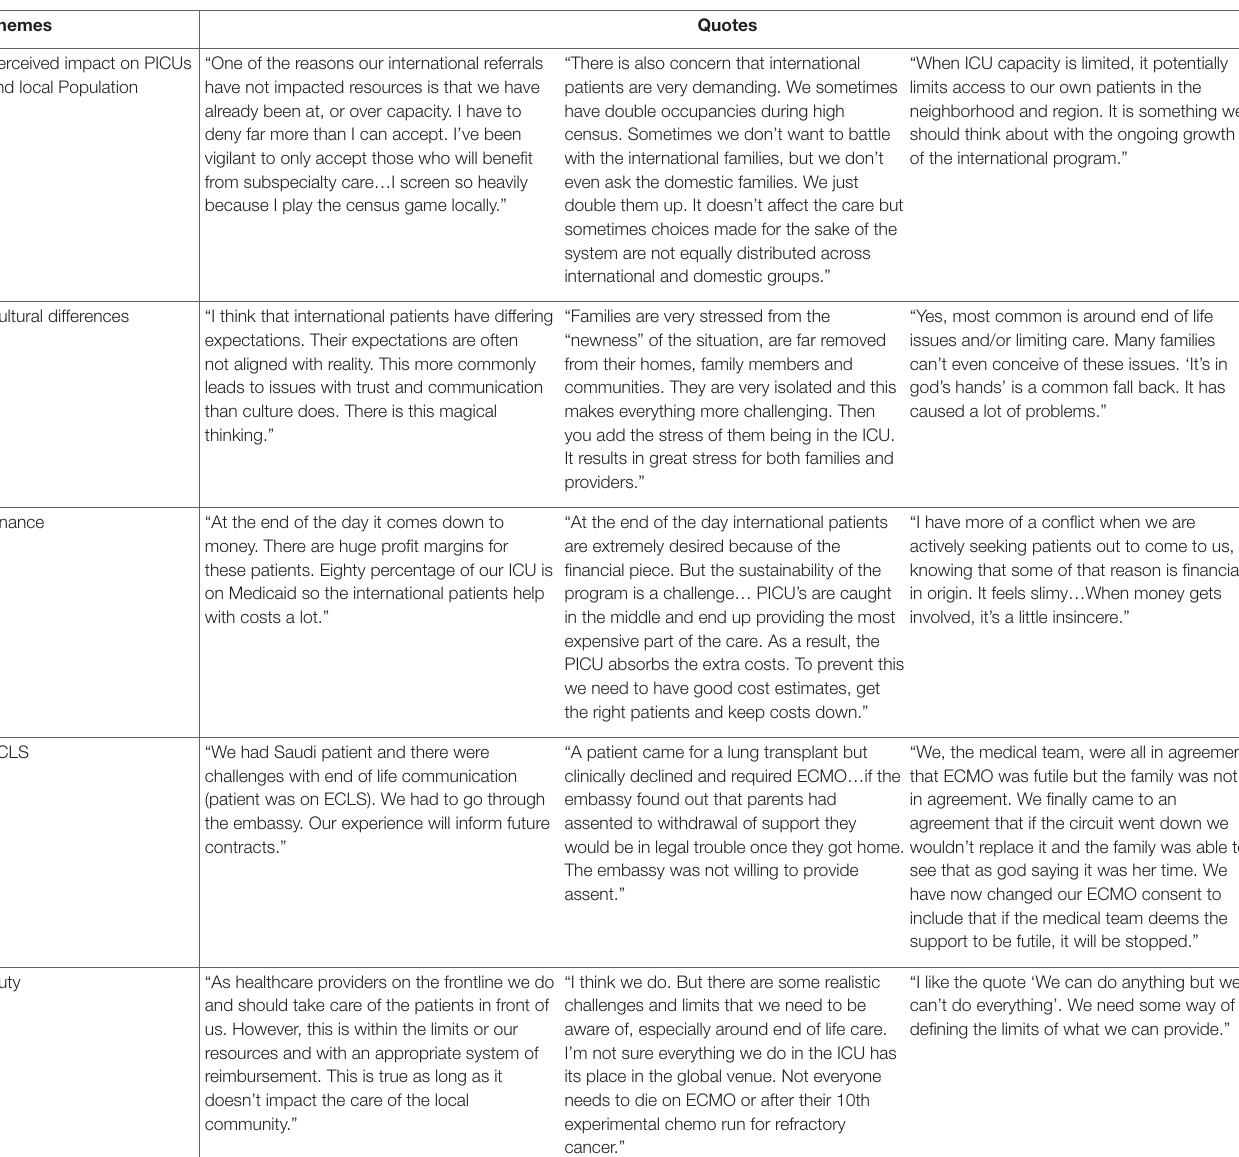
TABLE 2 | Example quotes regarding the impact of international patients on the delivery of pediatric critical